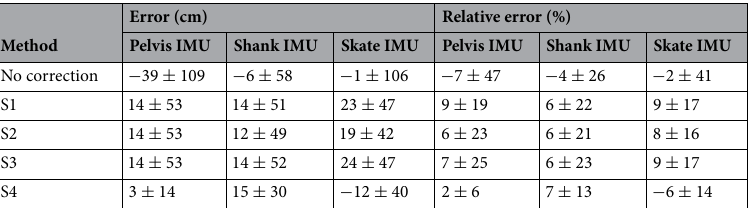
Table 4. The mean and standard deviation (mean ± SD) for errors and relative errors of the stride length (SL) obtained by IMUs’ readout against the SL calculated based on markers trajectory captured by the motion- capture cameras. The errors were calculated with and without applying the velocity correction methods (S1–S4, described in Table 2) using IMUs placed on the participants’ pelvis, shank, and skates.